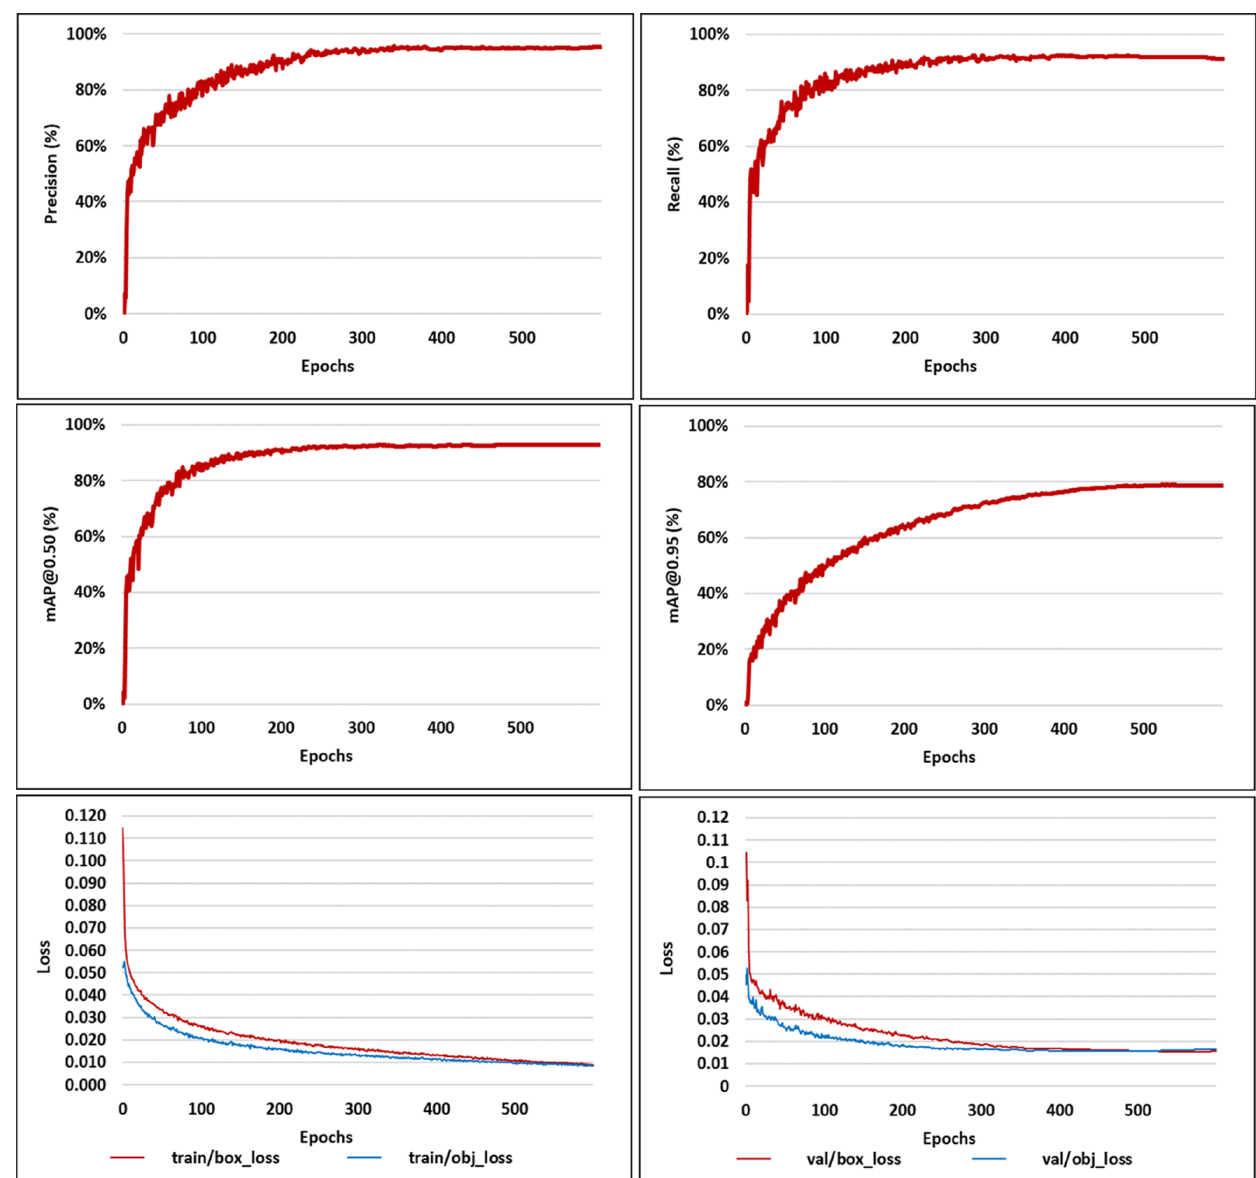
Figure 9. Visual analysis of YOLOv5 evaluation indicators during training.